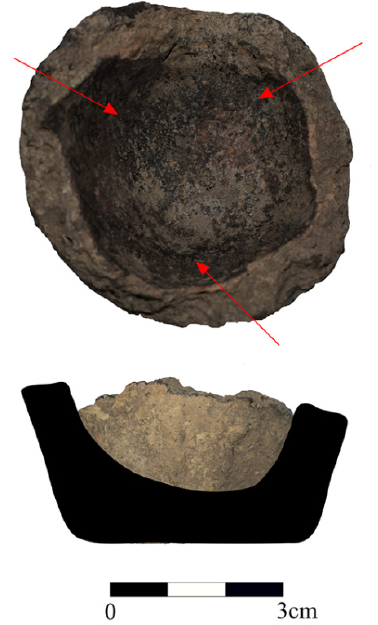
Figure 4. Sample L11 (top) interior of the vessel; (bottom) outside of the vessel.